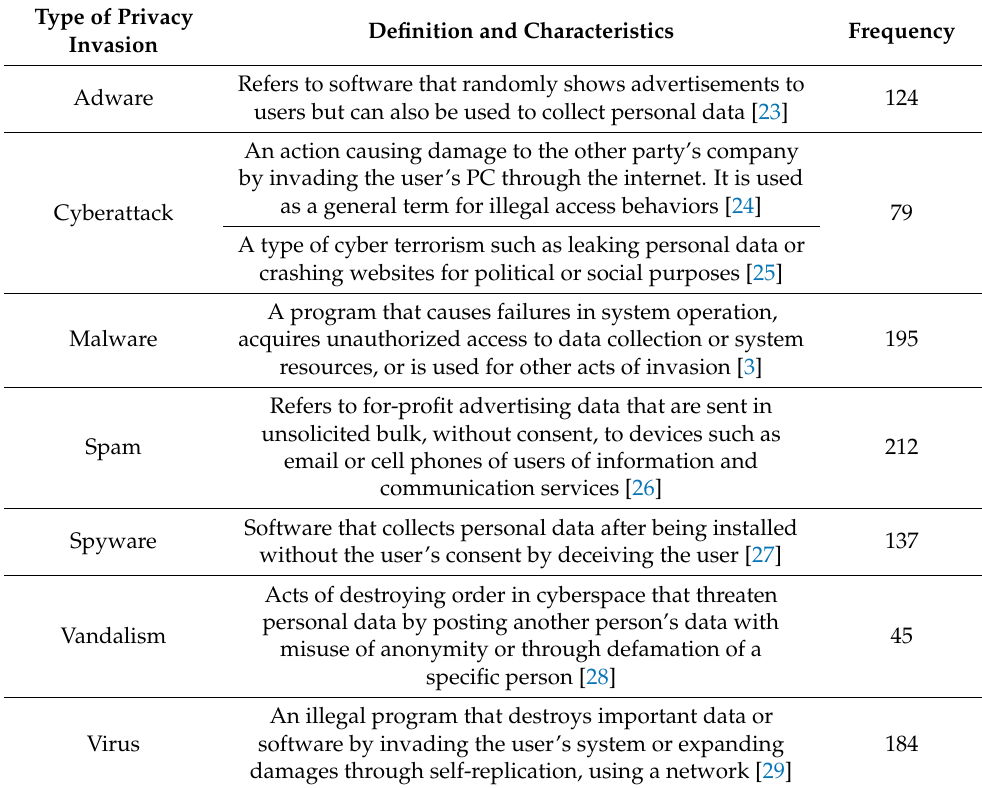
Table 2. Definition and Frequency of Privacy